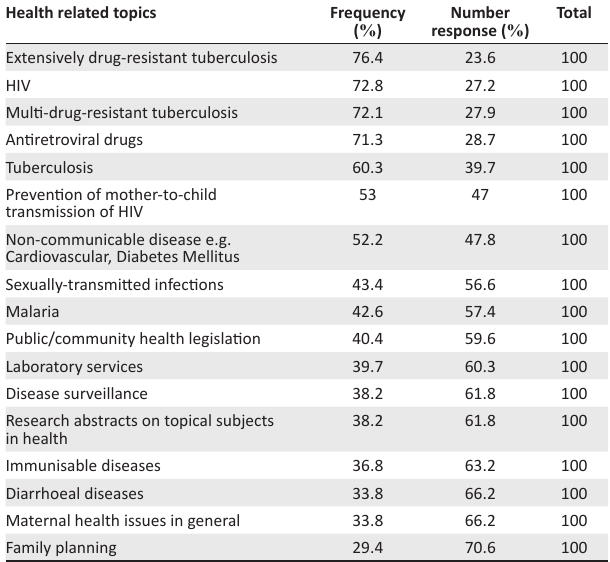
TABLE 3: Information identified as a requirement at the point of care ( n = 136).